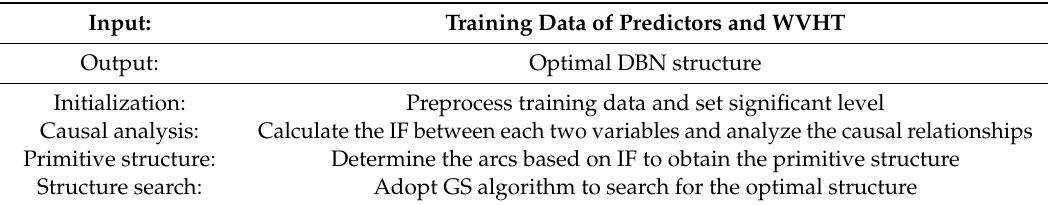
Table 6. Algorithm scheme of AGS.